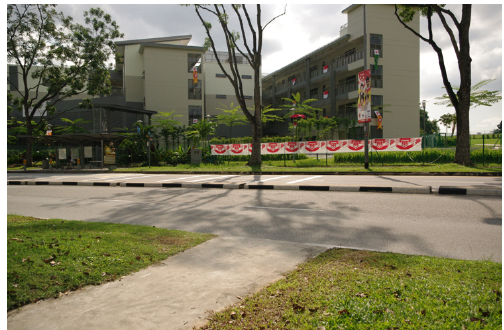
Figure 3: Sample image of building from Stimulated